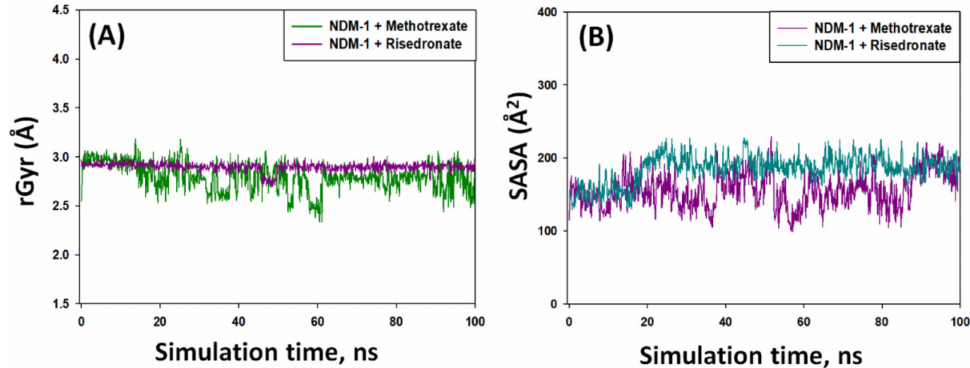
Figure 4. Variation in the ( A ) radius of gyration (rGyr) and ( B ) solvent accessible surface area (SASA) of NDM-1–risedronate and NDM-1–methotrexate